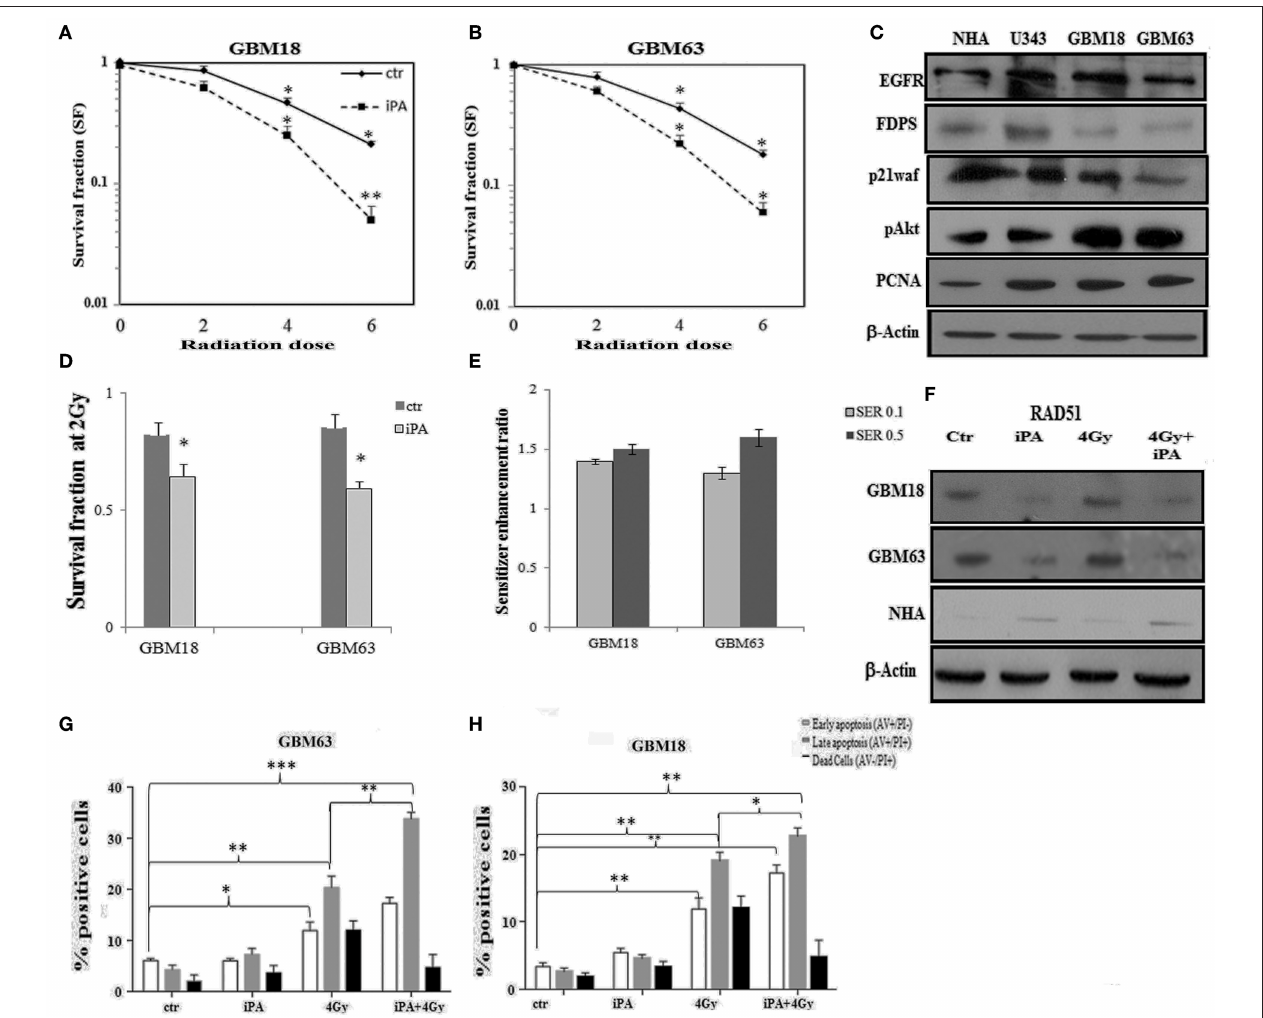
FIGURE 7 | Effect of iPA on tumor cell radiosensitivity on primary glioblastoma cells. (A,B) Clonogenic survival curves for GBM18 and GBM63 cells were exposed to 1 µ M of iPA or DMSO for 48h and irradiated with increasing doses of X-rays, followed by an additional 24h post-irradiation incubation in iPA contaning medium. The results shown represent the average of 3 independent determinations. (D) The survival fraction after 2-Gy (SF2) of human primary glioblastoma cells. Values are the mean survival fraction ± SD of at least 3 independent experiments (ANOVA * p < 0.05). (E) Sensitizer enhancement ratios (SER) were calculated at 10% or 50% cell survival (0.1 or 0.5) (C) Representative Western blot showing the basal protein levels of EGFR, p21waf, p-AKT, AKT, FDPS, and PCNA in the primary human glioblastoma cells. (F) Western blot showing the RAD51 protein levels in GBM18, GBM63, and in NHA cells. β -actin was used as loading control. (G,H) Flow cytometric analysis of Annexin V and propidium iodide (PI) double staining in GBM18 and GBM63 cells. Histograms show the total percentage of early (Annexin V-positive cells/PI-negative cells) and late apoptotic events (Annexin V/PI-double positive cells) as well as necrotic cells (Annexin V-negative cells/PI-positive cells). Results are representative of 5 experiments performed in duplicate and expressed as mean ± SD (ANOVA * p < 0.05, ** p < 0.01, *** p <